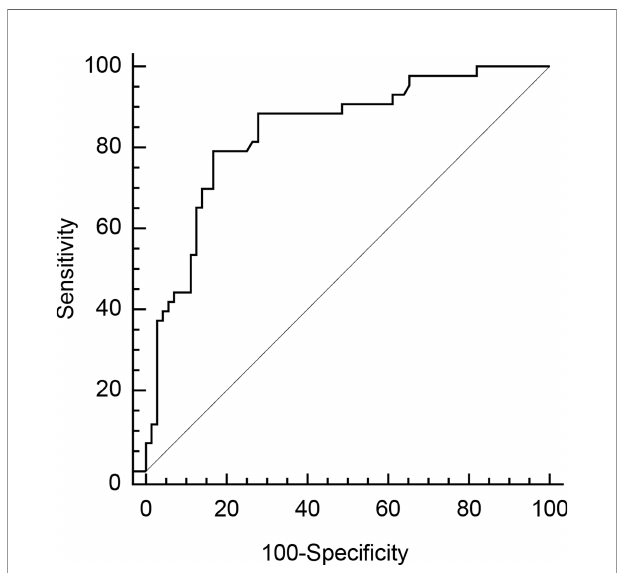
FIGURE 3 | Receiver operating characteristic (ROC) curve analysis of AmygA to identify osteoporosis in postmenopausal women. The optimal cut-off value was chosen by the maximum Youden index [sensitivity − (1 − speci fi city)] on the ROC curve.